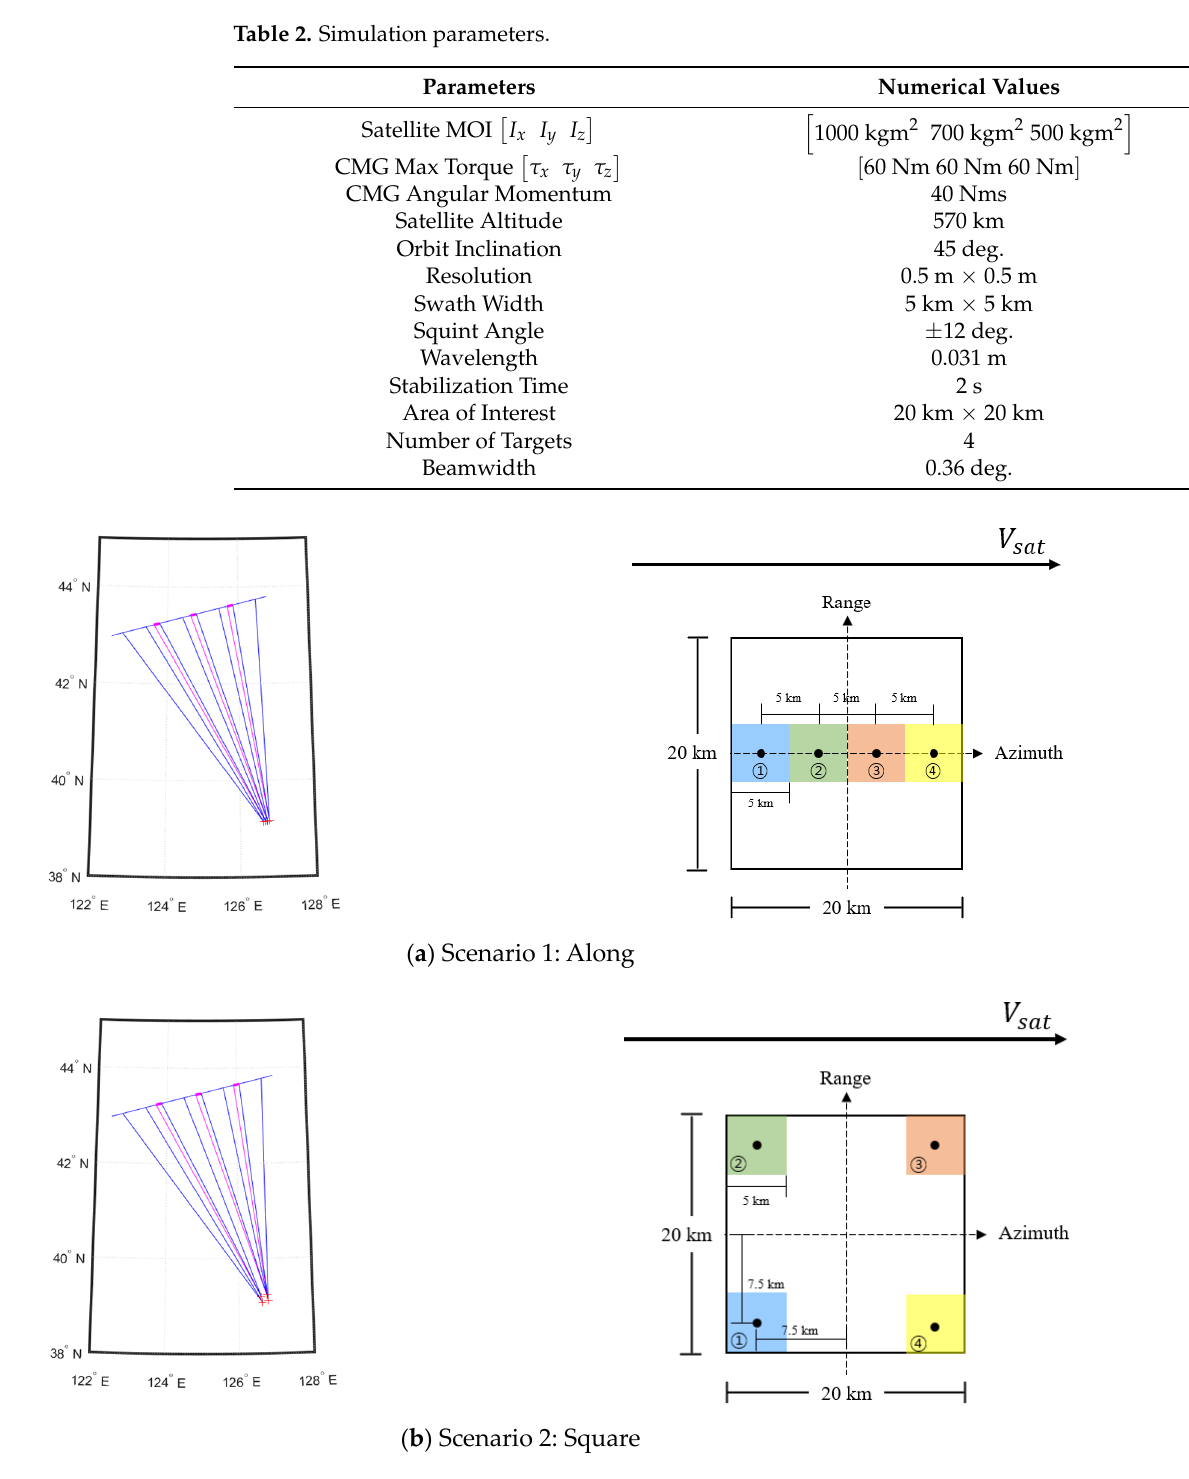
Figure 13. Target scenarios for maneuvering simulation.